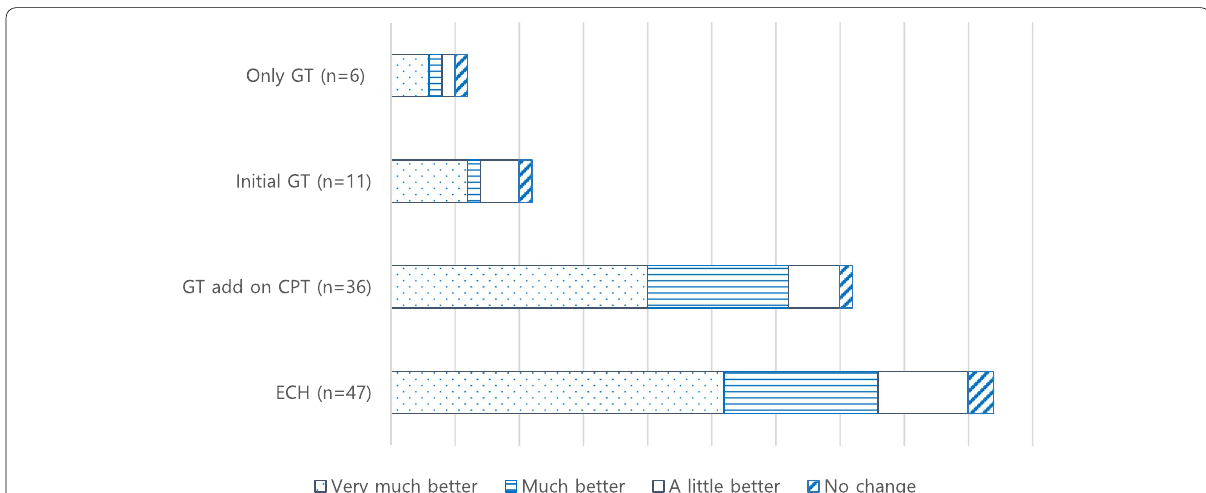
Fig. 2 Patient global impression of improvement of galcanezumab therapy. GT galcanezumab therapy. CPT conventional preventive therapy, ECH episodic cluster